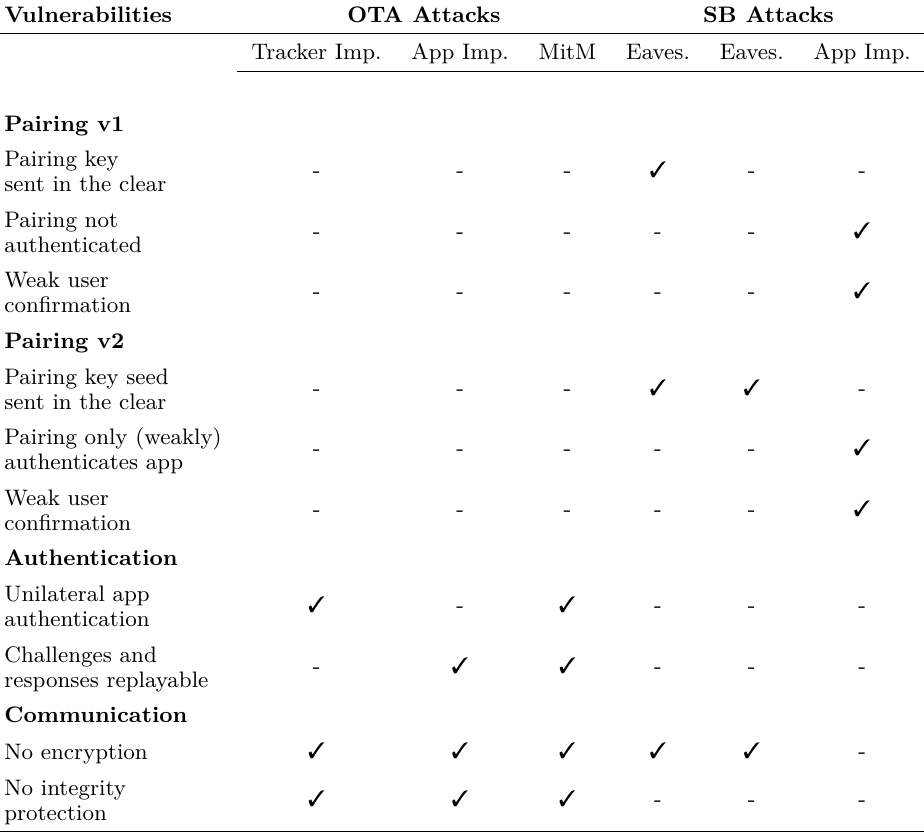
Table 1: Mapping between the exploited vulnerabilities identified in Section 3.2 and the OTA and SB attacks presented in Section 4. A checkmark ( (cid:51) ) indicates that a vulnerability is exploited to conduct an attack. Vulnerabilities OTA Attacks SB Attacks Tracker Imp. App Imp. MitM Eaves. Eaves. App